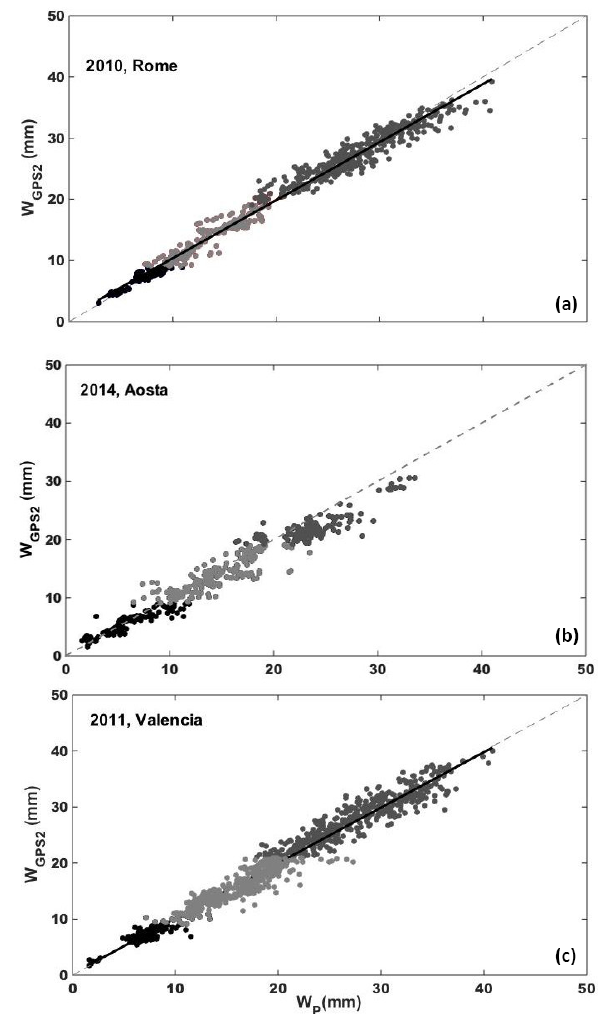
Figure 5. Scatter plot of W GPS2 vs. W P . Alternations of black and greys indicate the three water vapour classes.